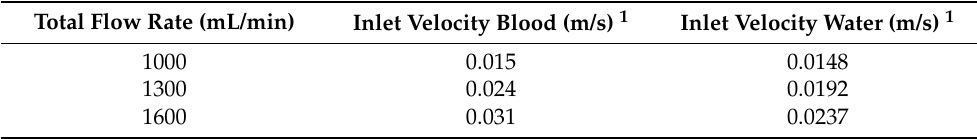
Table 2. Inlet velocities of reduced geometry determined with up-scaling method